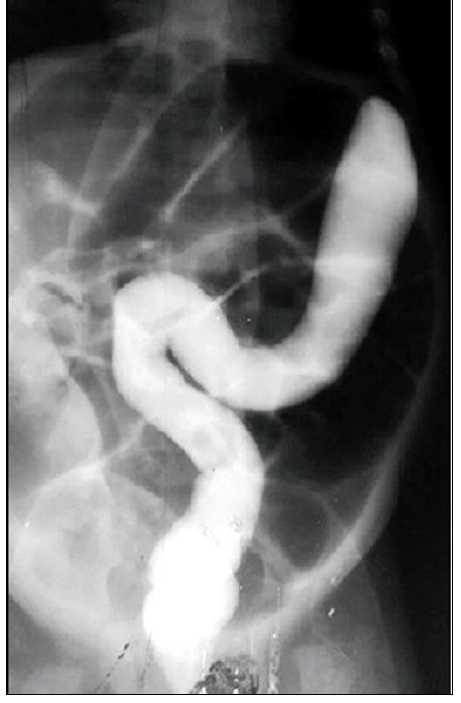
Figure 1: Barium enema showing contrast not trav- ersing beyond the splenic flexure.